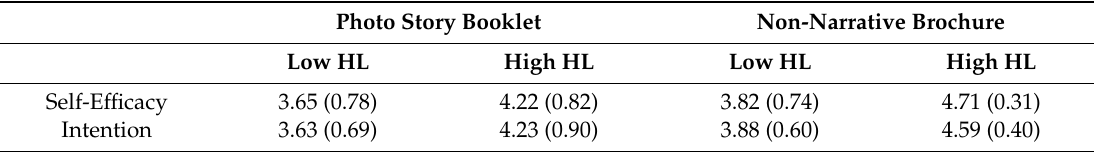
Table 3. Average levels of self-e ffi cacy and behavioral intention for both conditions for each Health Literacy Group (means and standard deviations) in the